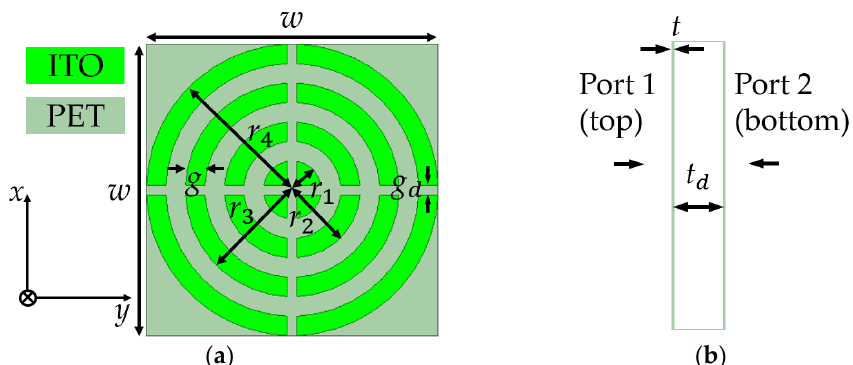
Figure 1. Proposed unit cell design for the MTM absorber. ( a ) Top view, and ( b ) Side view. Design parameters: w = 15, r 1 = 1.5, r 2 = 3.5, r 3 = 5.5, r 4 = 7.5, g = 1, g d = 1, t = 0.175, and t d = 3. All units are in millimeters.